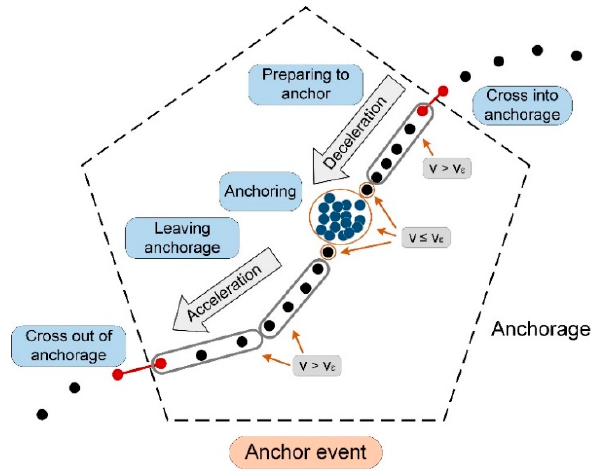
Figure 7. Anchor event of ship occurred in anchorage.